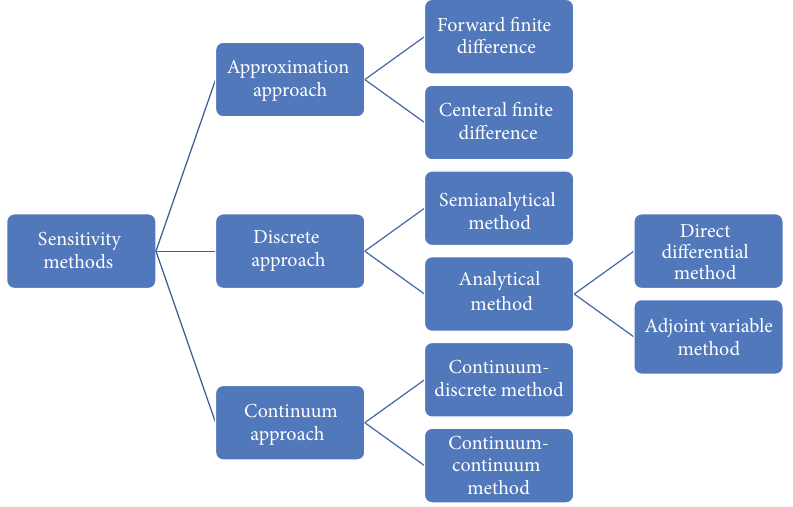
Figure 2: Approaches to design sensitivity